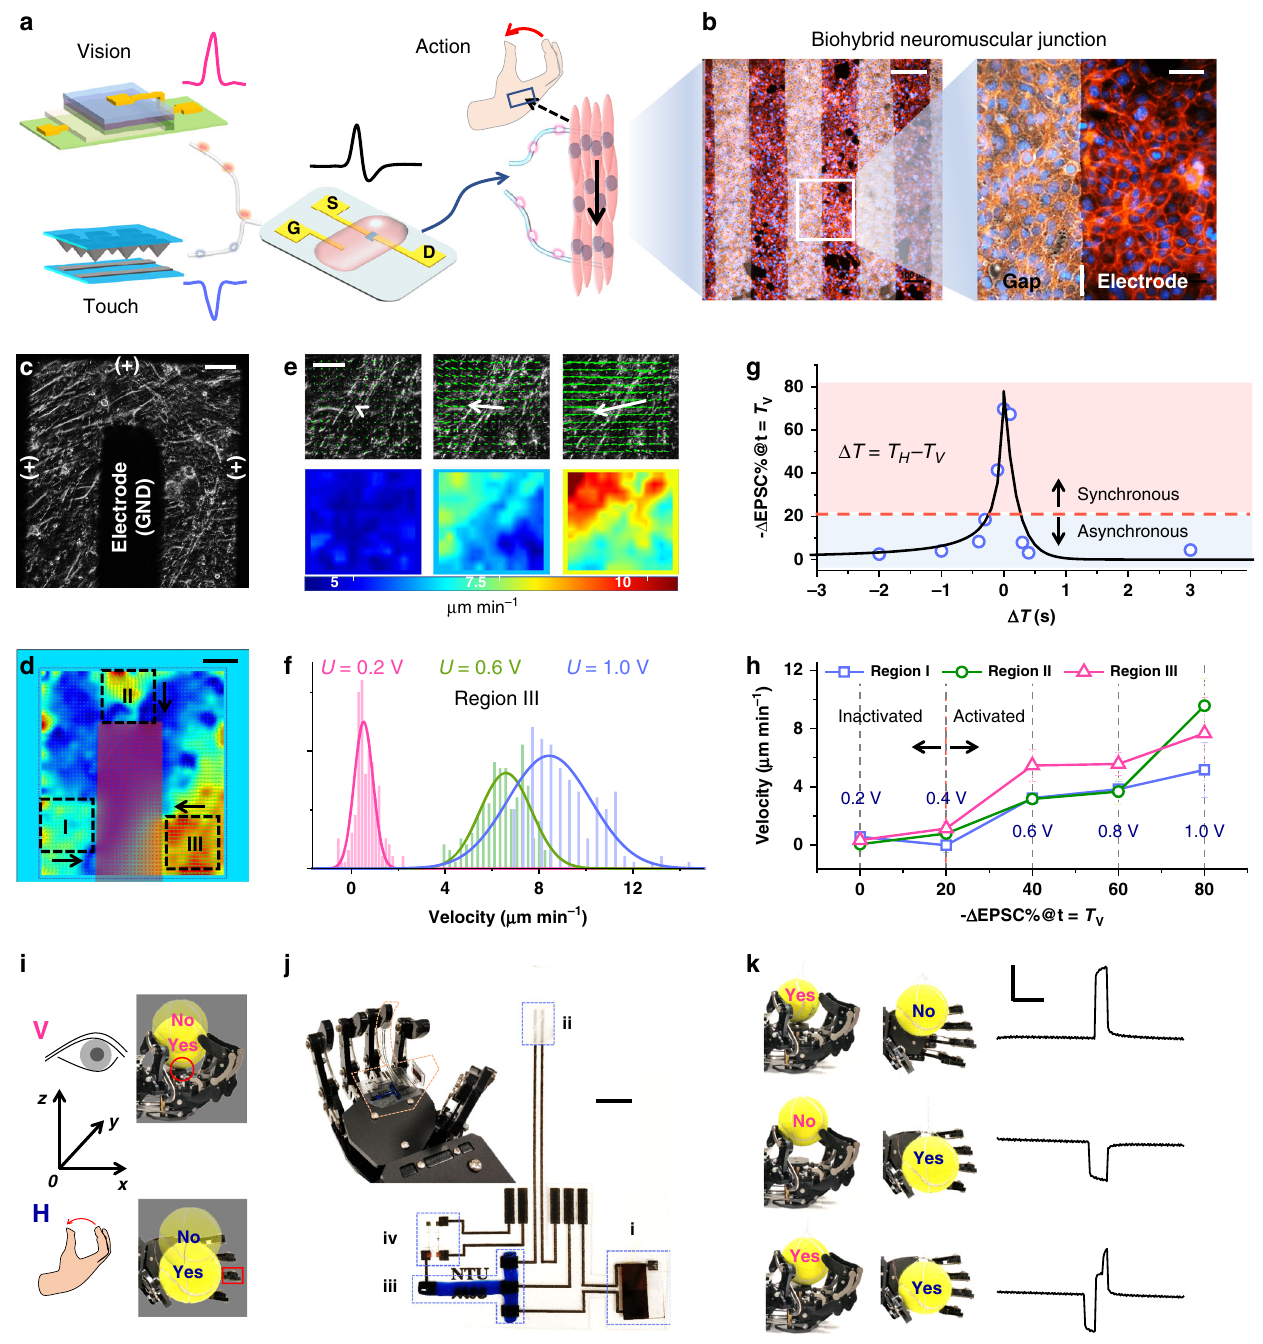
Fig. 3 The visual-haptic fusion based on BASE patch for motion control. a The schematic of visual-haptic fusion for muscle actuation. b Confocal fl uorescent imaging of biohybrid neuromuscular junction. The scale bar is 200 μ m (left) and 50 μ m (right), respectively. c Phase contrast image of a target- area (7.3 × 7.3 mm 2 ) in the biohybrid neuromuscular junction. The scale bar is 1 mm. d Representative speed magnitude mapping of the target-area under 1.0 V stimulation. Region I to III indicate three robust regions of interest. The arrows indicate the dominant myotubes motion direction. The scale bar is 1 mm. e Representative mapping of the velocity vector (upper row) and speed magnitude (| v |, lower row) in Region III, under stimuli of 0.2 V, 0.6 V, and 1.0 V bias. The white arrows indicate the mean velocity vector. The scale bar is 200 μ m. f Histogram plot of the motion velocity under 0.2 V, 0.6 V, and 1.0 V. Solid curves: Gaussian fi tting of the histogram. g Plot of the relative change of Δ EPSC% as a function of the time interval ( Δ T ). The voltage applied on the photodetector and pressure sensor is positive ( V V = 1.0 V) and negative ( V H = − 1.0 V), respectively. In all, 20% is de fi ned as the criterion of synchro- nization. h The mean speed of region I to III in response to different EPSC changes. The texts in blue indicate the applied voltage converted from Δ EPSC%. i The “ YES ” and “ NO ” positions inferred by visual (top, pink) or haptic (bottom, blue) feedback. If the ball could be held by the robotic hand based on one sensory feedback, then the position is annotated as “ YES ” otherwise “ NO ” . j The modi fi ed BASE patch on the robotic hand and the magni fi ed image of the BASE patch. The scale bar is 5 mm. k The Δ EPSC of the BASE with the ball at different positions ( V = YES, H = NO; V = NO, H = YES; V = YES, H = NO) through the exploration process. The scale bars are 1 μ A and 1 s for y -axis and x -axis,